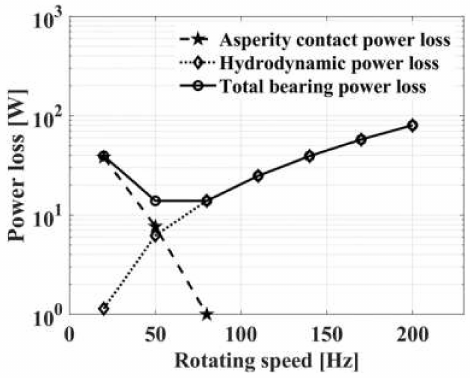
Figure 10. Asperity contact, hydrodynamic, and upper journal bearing power